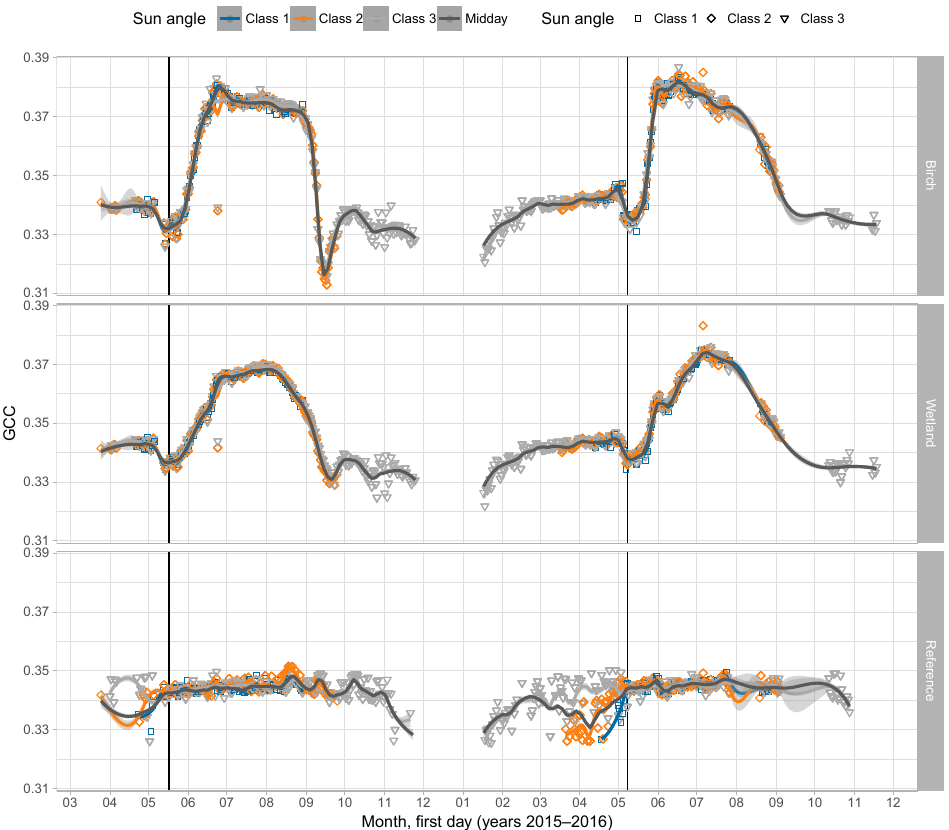
Figure 4. Daily GCC time series of ROI in Kaamanen site by solar elevation category – class 1: >30 ◦ ; class 2: (20, 30 ◦ ); class 3: (0, 20 ◦ ) – and as daytime averages (midday: 10:00–14:00UTC + 2) and smoothed development of GCC over the years. Vertical line shows the snowmelt date, i.e. the first day without any